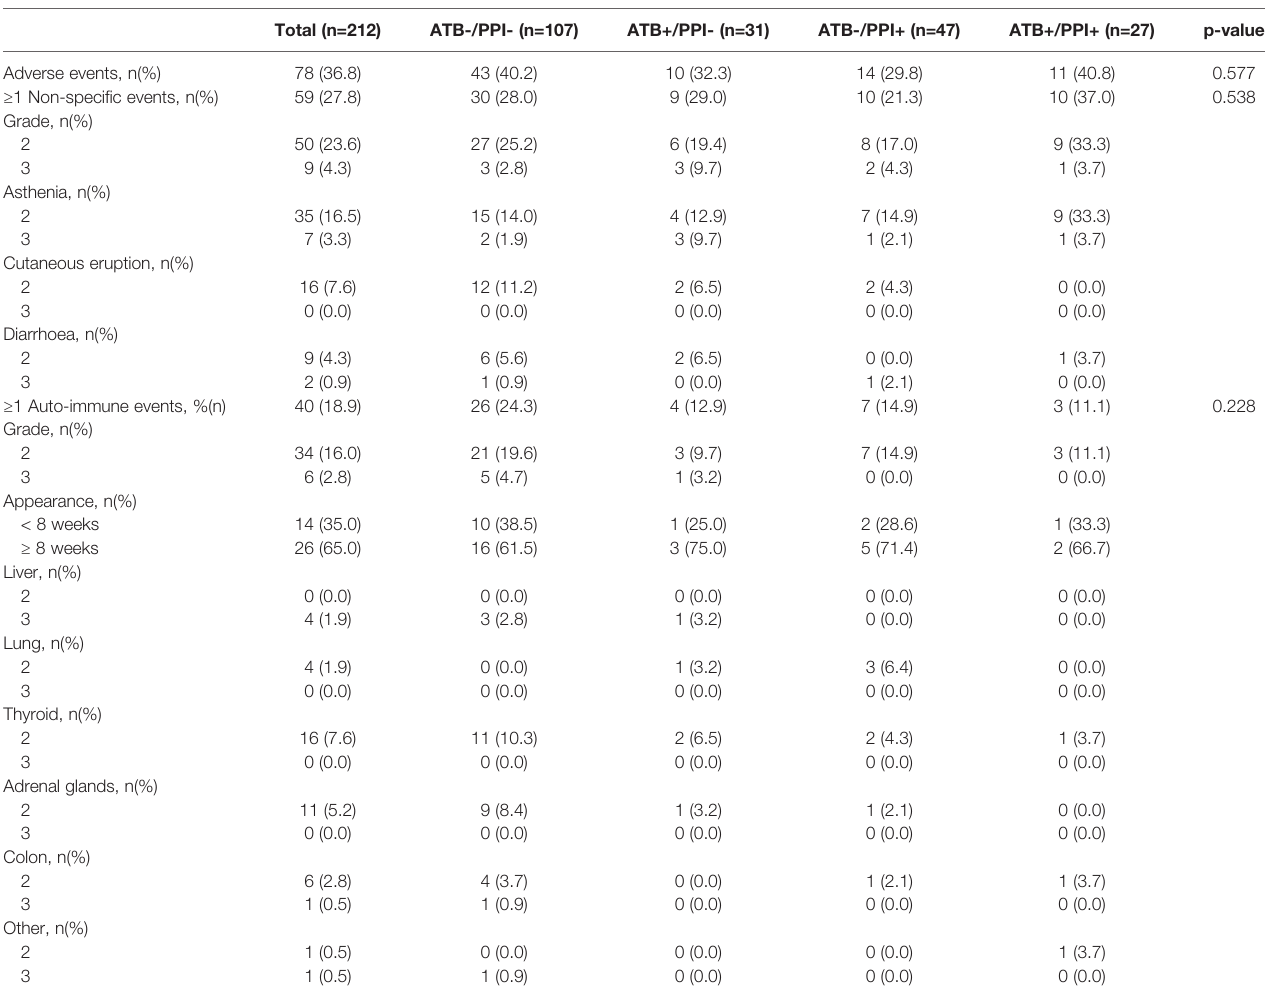
TABLE 5 | Adverse events in the whole population and in each